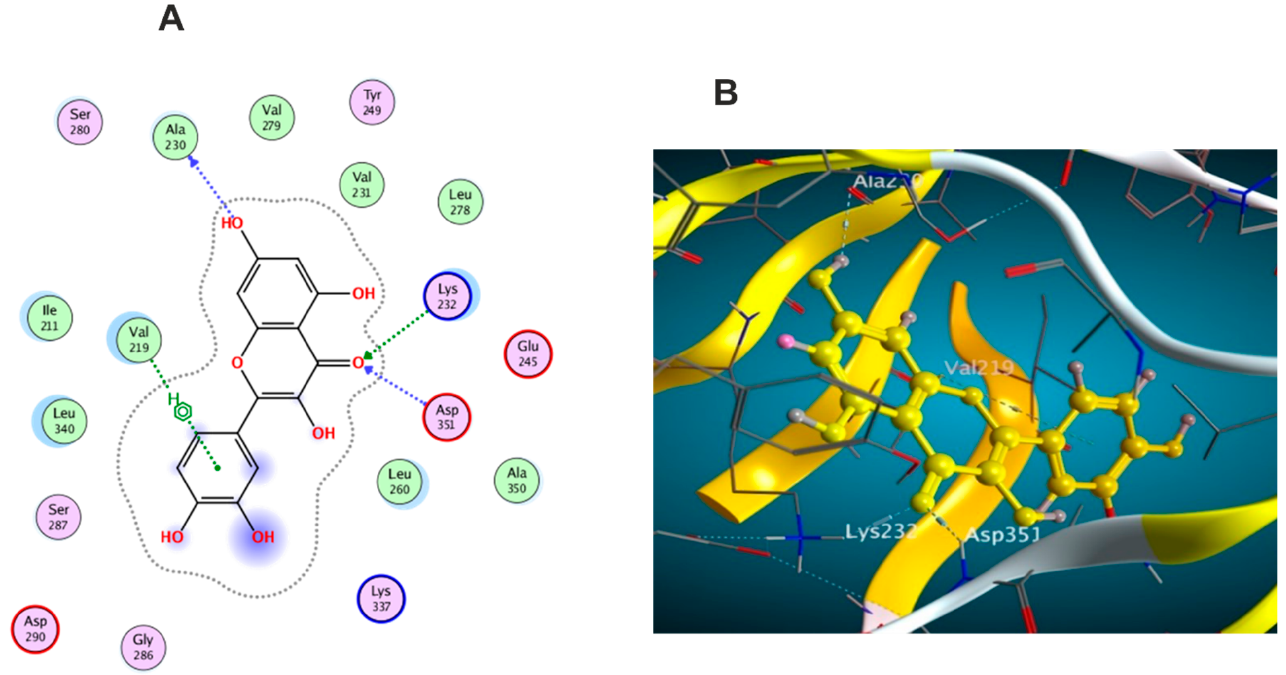
Figure 10. Docking results of compound 1 in the active pocket site of (TGF- β ) (6B8Y): ( A ) 2D interactions of compound 1 ( B ) 3D Docking pose of compound 1 .